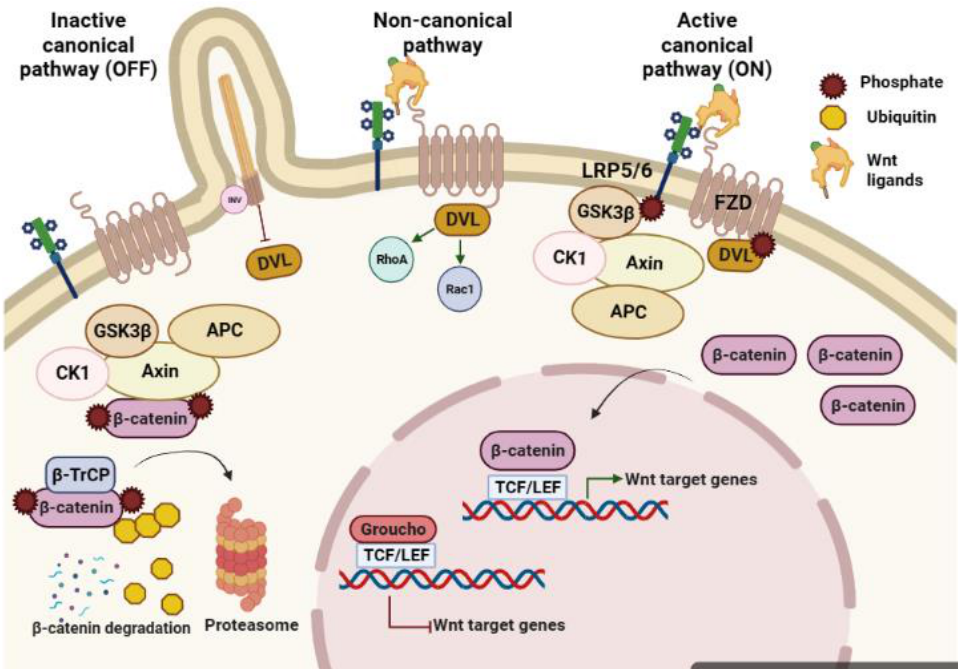
Figure 1. Schematic representation of canonical and non-canonical Wnt signaling pathways in cholangiocytes and the role of the primary cilia in modulating these pathways. In the absence of Wnt ligands (inactive, canonical Wnt/β -catenin pathway OFF), β -catenin is degraded by the destruction complex, and Wnt target genes are silenced. In the presence of Wnt ligands (active, Wnt/β -catenin pathway ON), β -catenin accumulates in the cytoplasm and translocates to the nucleus, promoting the expression of Wnt target genes. Furthermore, in the presence of Wnt ligands, the non-canonical pathway stimulates planar cell polarity through activation of small GTPases Rho and Rac, which induce cytoskeletal rearrangements. APC, adenomatous polyposis coli; CK1, casein kinase 1; DVL, Disheveled; FZD, frizzled receptor; GSK3β, glycogen synthase ki nase 3 beta; INV, inversin; LRP5/6, low density lipoprotein receptor-related proteins 5/6; TCF/LEF, T-cell factor/lymphoid enhancer factor; β - TrCP, β -transducin repeats-containing protein. Created with BioRender.com (Accessed on 7 April 2023).